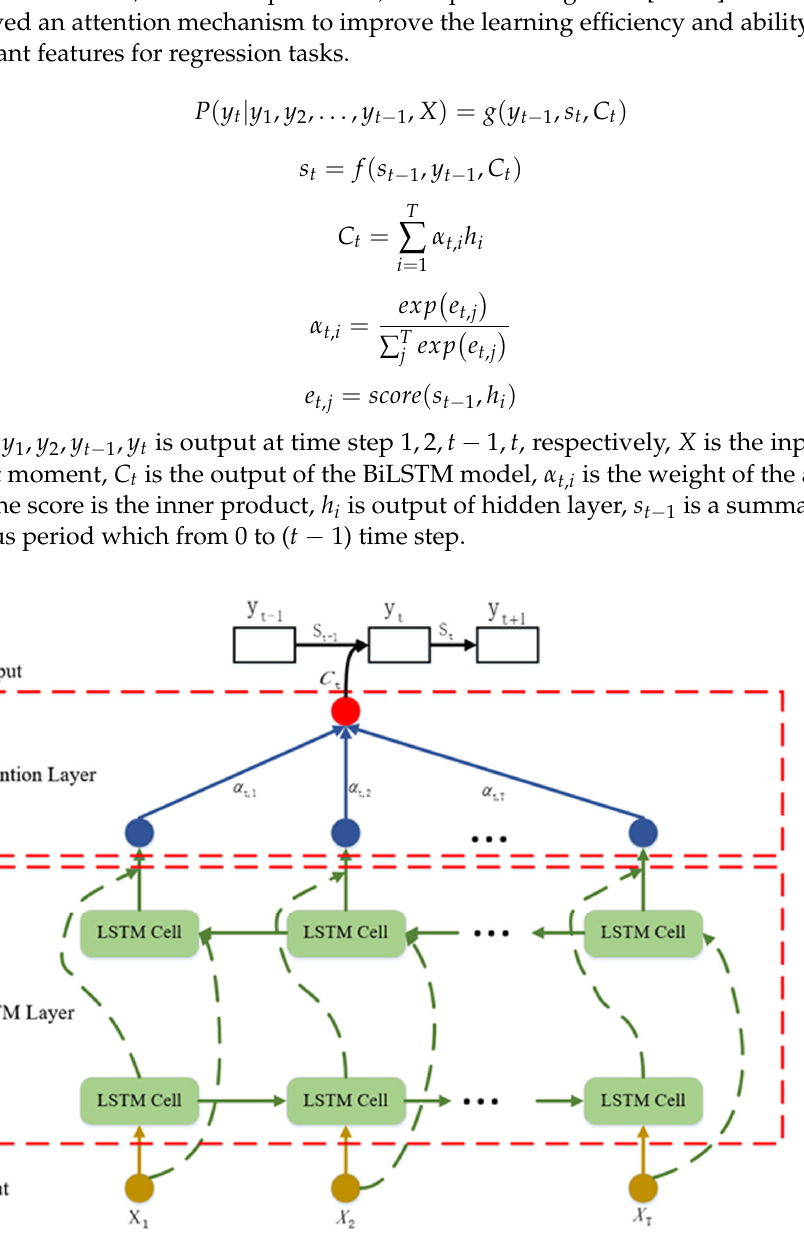
Figure 7. Schematic of BiLSTM Network.